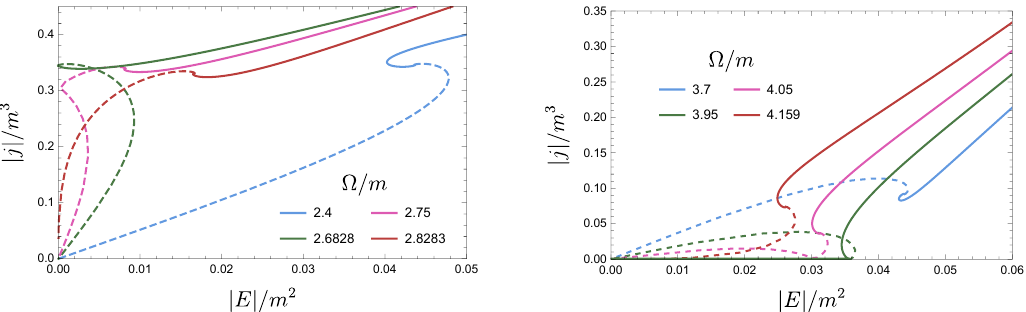
Figure 15 . Electric current | j | /m 3 versus electric field | E | /m 2 for r h /m = 0 . 001 . The solid curves represent the insulator (Minkowski) phase and the dashed curves the conductive (BH) phase. The driving frequency is fixed to some Ω /m < Ω c /m (blue), Ω /m = Ω c /m (green), Ω c /m < Ω /m < Ω m /m (pink) and Ω /m = Ω m /m (red). The curves the left, with Ω ∼ 2 . 68 scan the region close to the Floquet vector meson condensates and were obtained in [10]. On the right, for Ω ∼ 3 . 95 we do the same around the first Floquet suppression